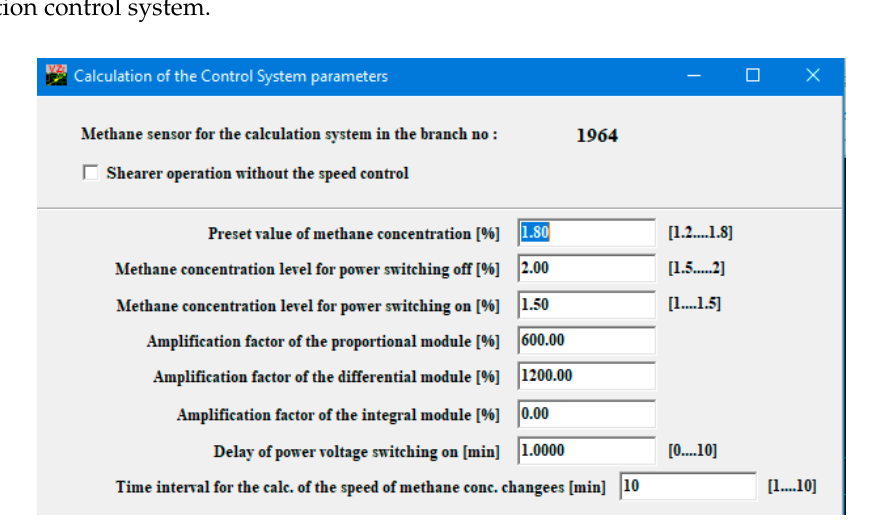
Figure 2. Parameters of automatic methanometry and the calculating circuit.